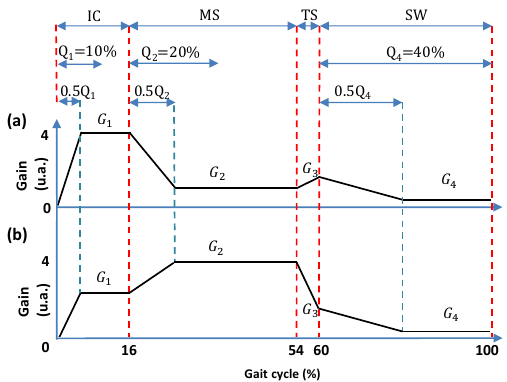
Figure 3. Percentage of each phase with respect to the gait cycle ( Q i ) taken into account in this approach for (a) gain pattern P 1 ; (b) gain pattern P 2 .